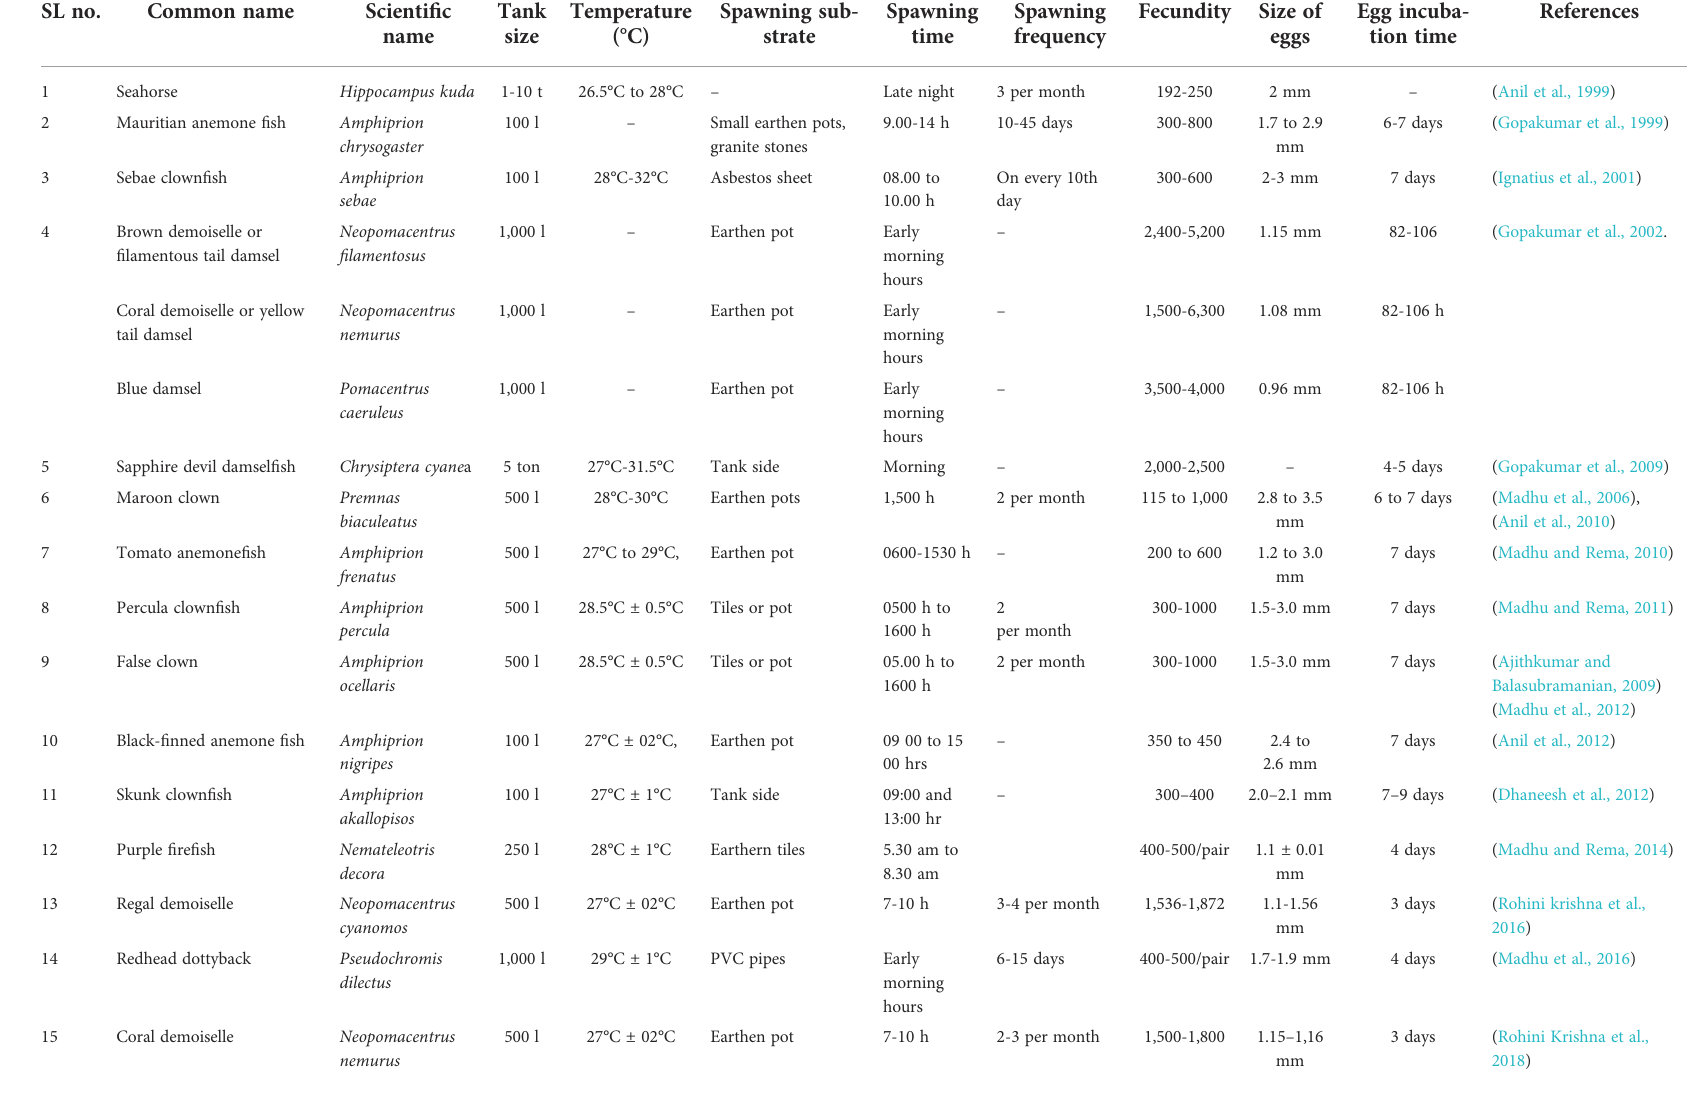
TABLE 1 Summary of natural spawning, environmental conditions, and reproductive features of marine ornamental fi sh carried out in India. SL